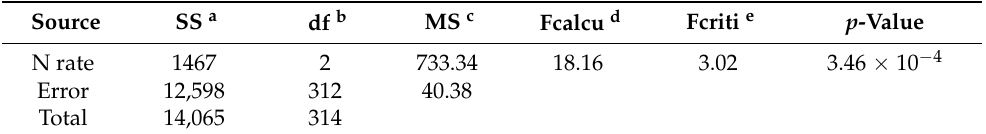
Table 3. ANOVA analysis on the mean leaf surface temperature data extracted from the first experi- ment, using IR handheld gun data.